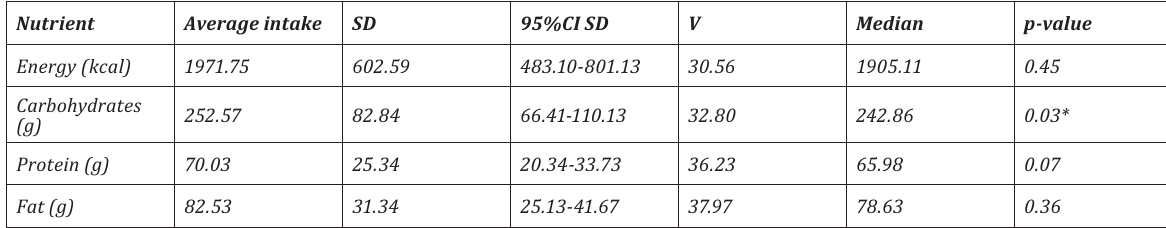
Table 2. Total energy and nutrients intake in the examined population